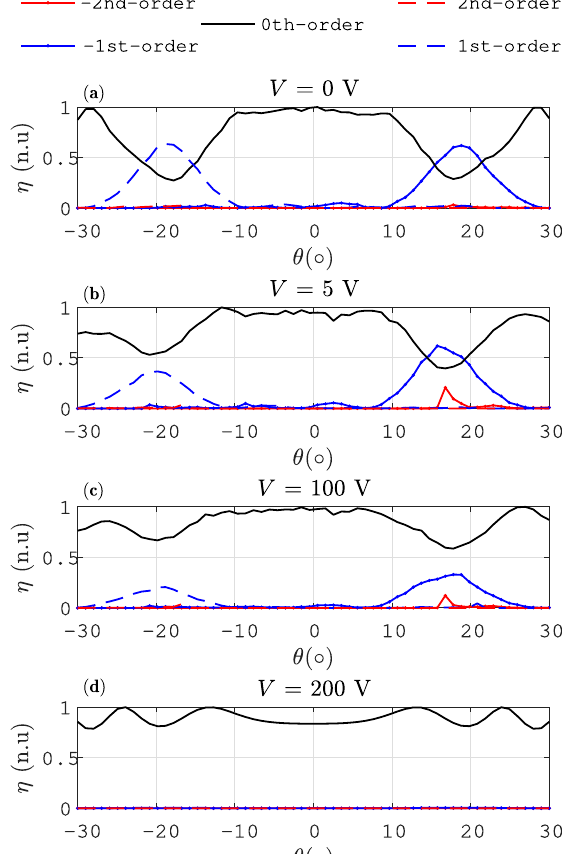
Figure 3. Diffraction efficiency for the orders ± 1st and 0th as a function of the angle of incidence θ 0 ( a ) Φ = 0 V. ( b ) Φ = 5 V. ( c ) Φ = 100 V. ( d ) Φ = 200